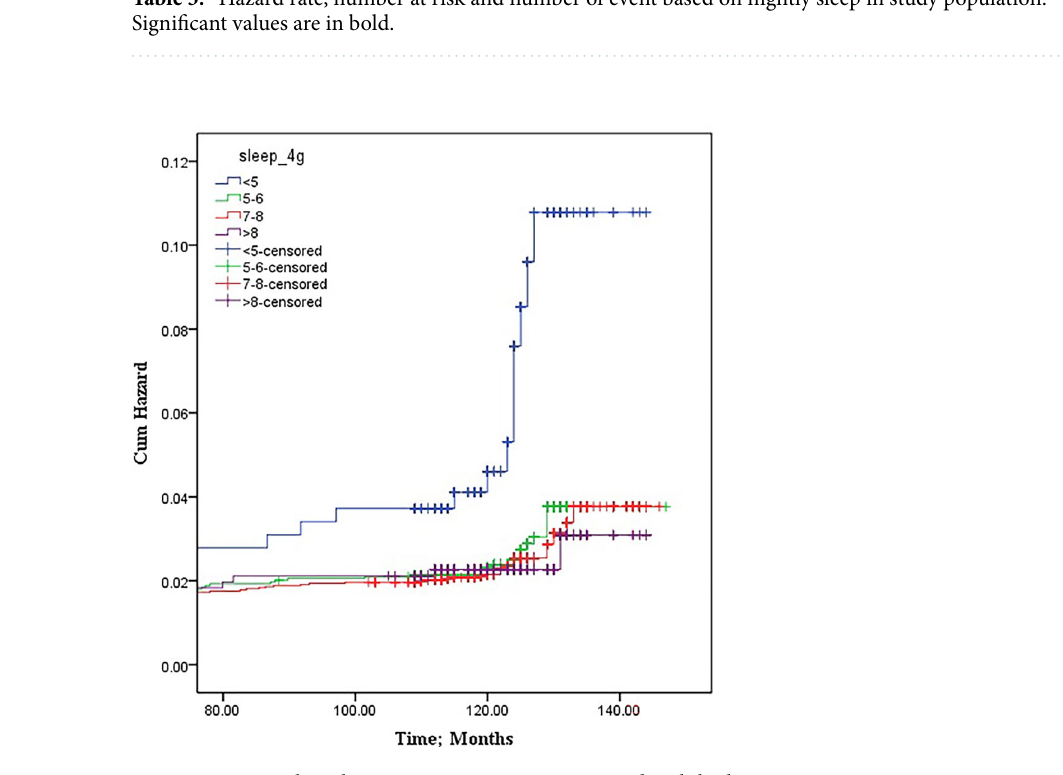
Figure 3. Survival Kaplan-Meyer curve, CHD events and nightly